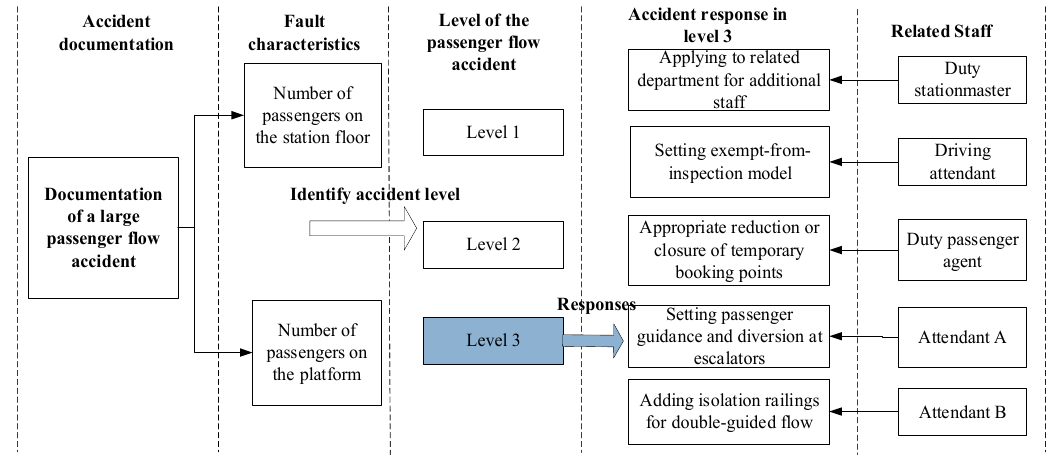
Figure 11. The handling process of a large passenger flow accident.